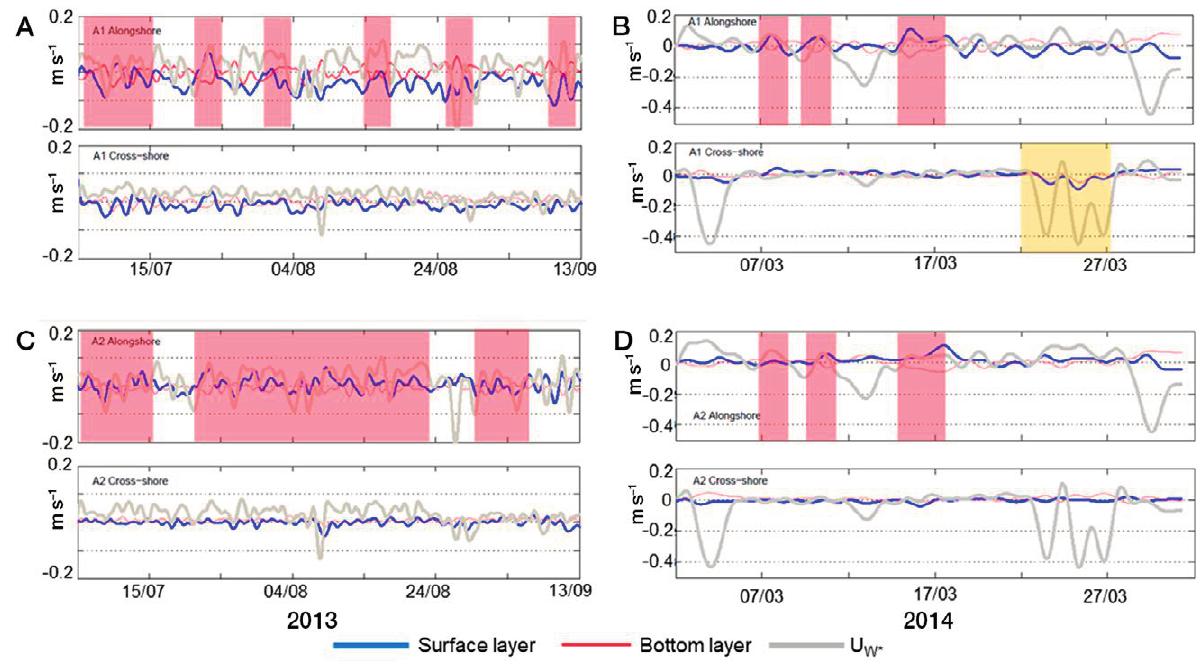
Fig 5. – Summer A1 (A) and A2 (C) filtered time series of uW* , surface (blue) and bottom currents (red). Both wind and currents are plotted following the rotated axis: 21° and 42° anticlockwise for A2 and A1, respectively. Red shaded areas indicate instances of qualitatively relevant correlation between alongshore surface currents and the corresponding winds. Orange shaded areas indicate relevant correlations with the cross-shore currents. Panels B and D show the same parameters in